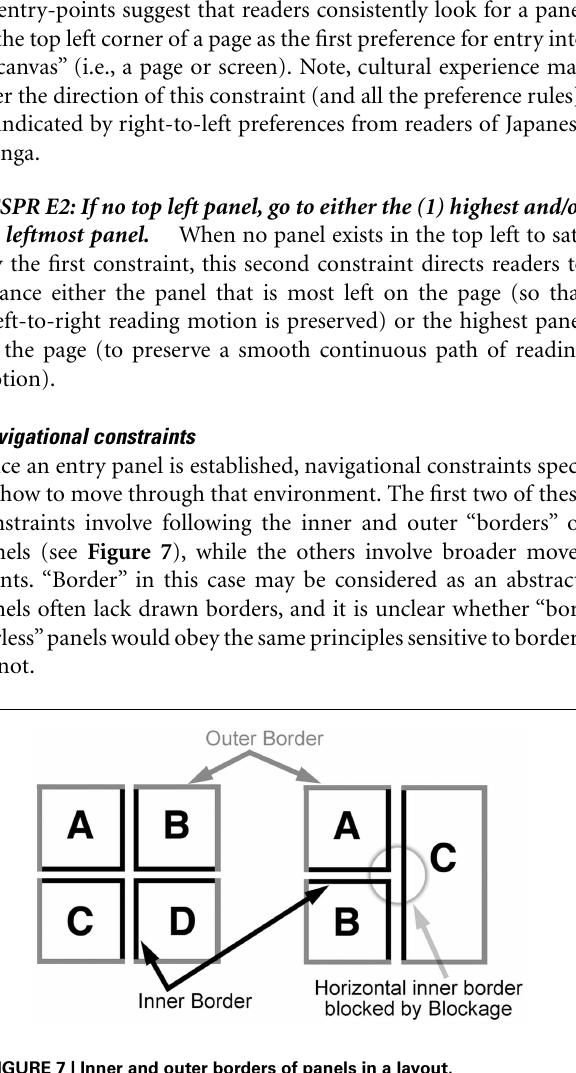
FIGURE 7 | Inner and outer borders of panels in a